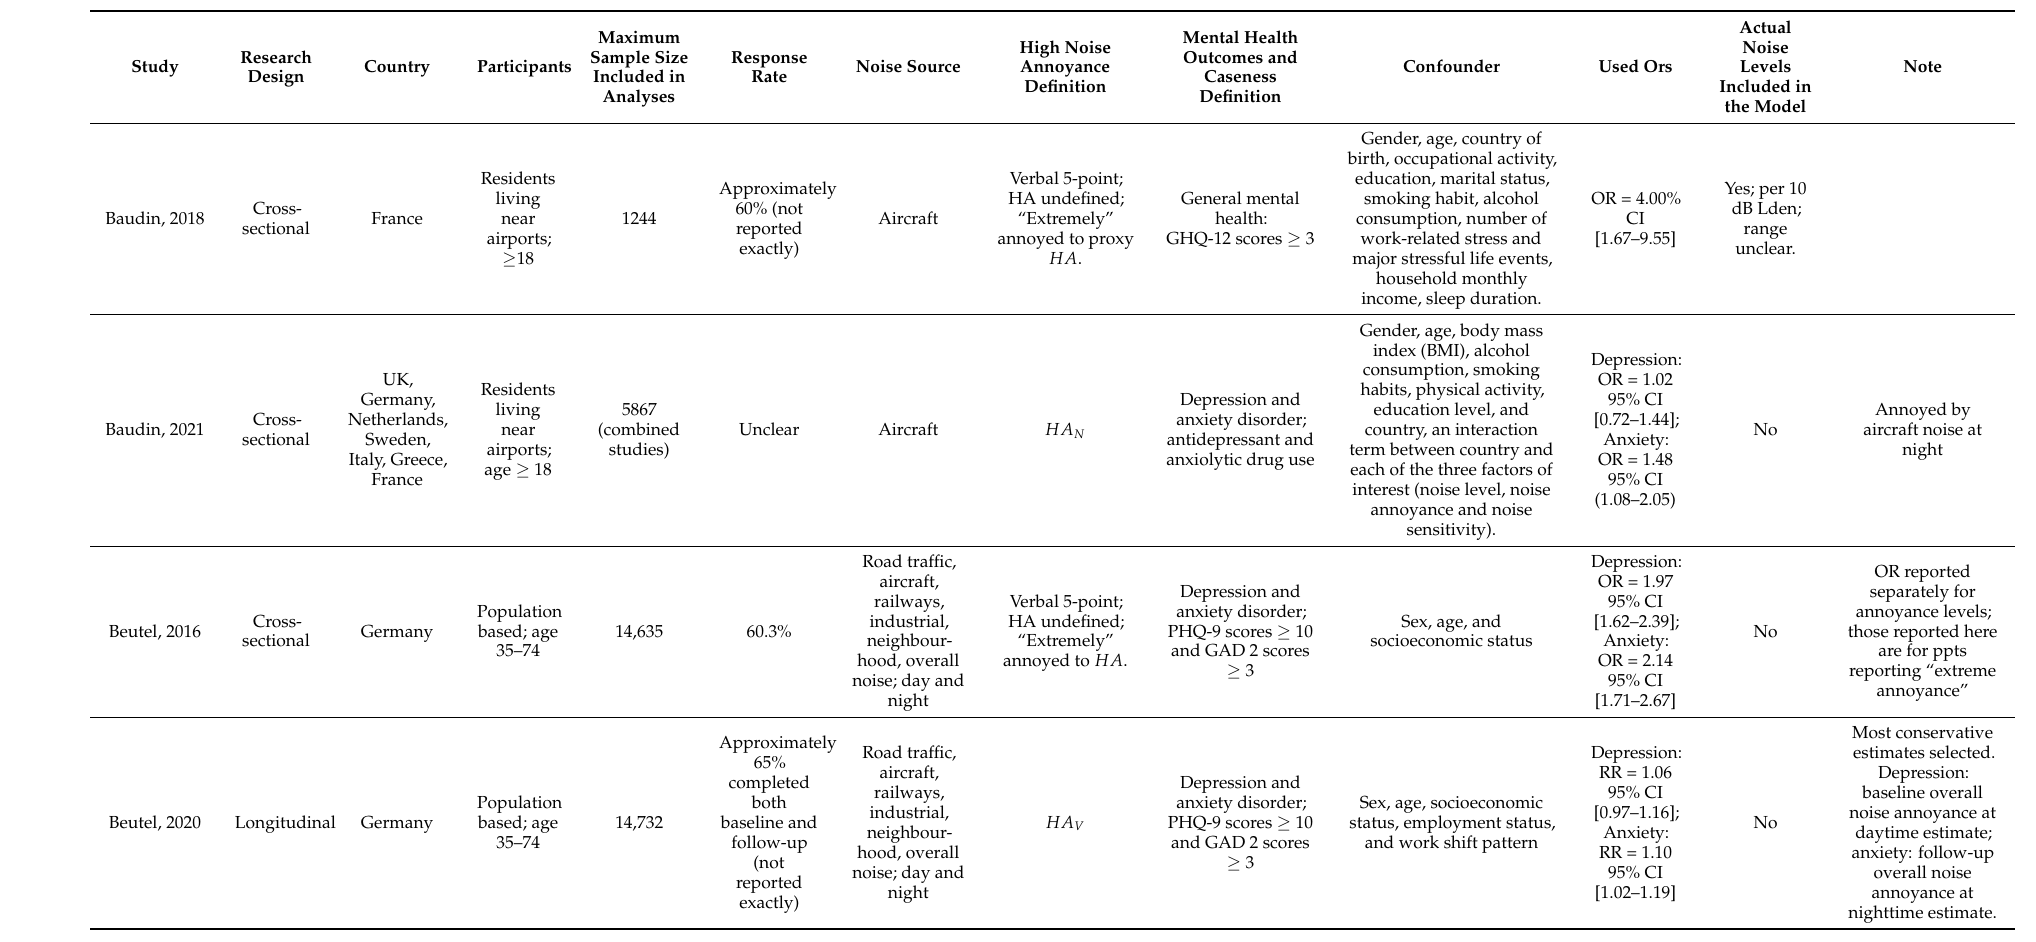
Table A6. Full description of